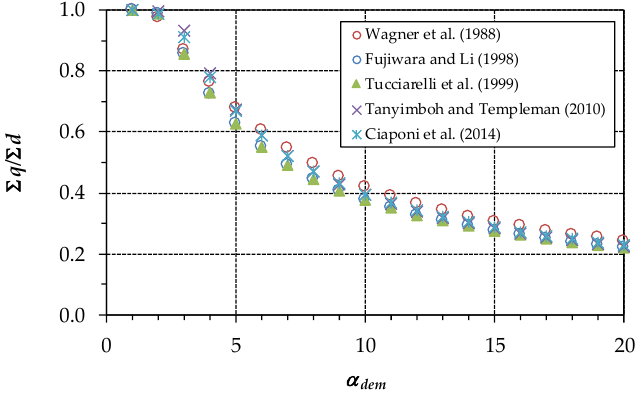
Figure 10. Second case study. Satisfaction rate ∑ q /∑ d for the various formulations as a function of α dem .